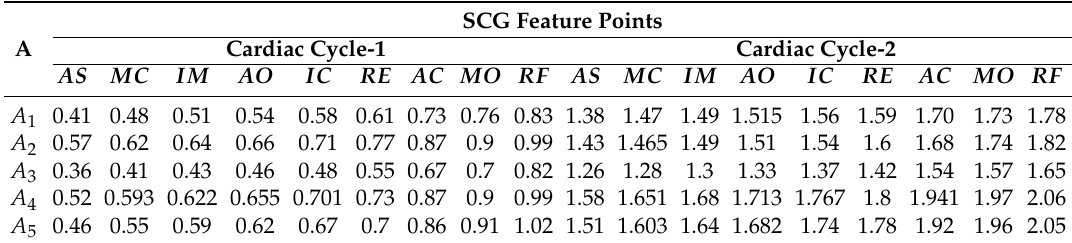
Table 12. Delineation of SCG feature points with corresponding time instances.